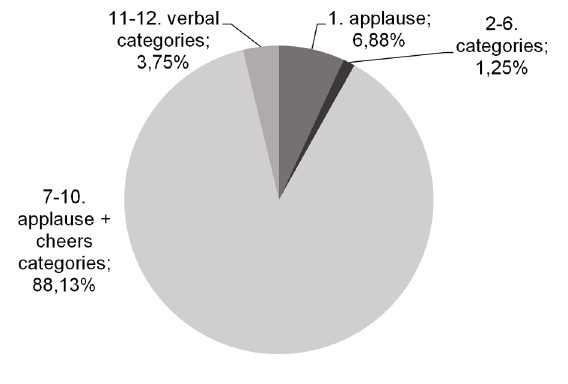
Figure 1. Collective audience responses in acceptance speeches.